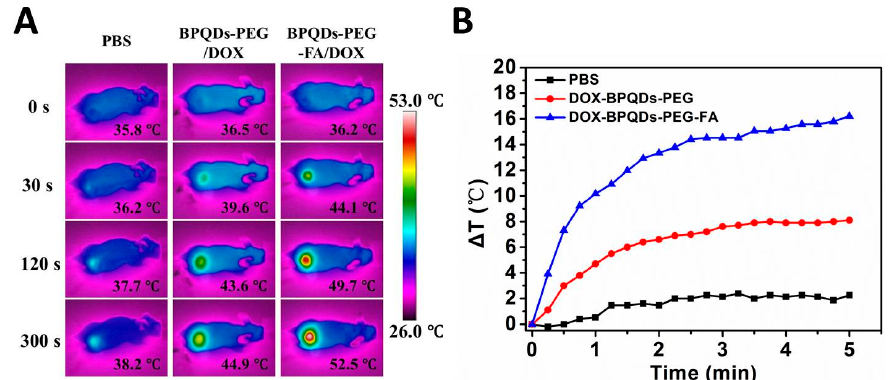
Figure 7. ( A ) Thermal images of HeLa tumor-bearing mice exposed to 808 nm laser (1.5 W cm − 2 ) after injection of PBS, BPQDs-PEG / DOX, and BPQDs-PEG-FA / DOX, respectively. ( B ) Time-dependent temperature increase of HeLa tumor-bearing mice recorded by an IR camera under 808 nm laser (1.5 W cm − 2 ).